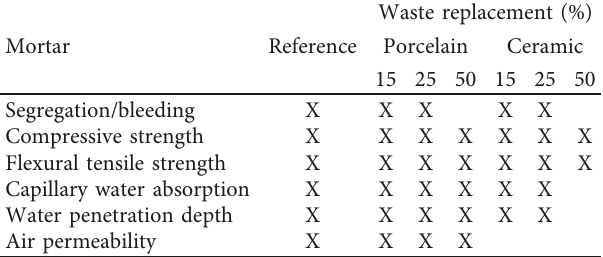
Figure 14: Air permeability results. Table 3: Overall assessment of SLM with waste.